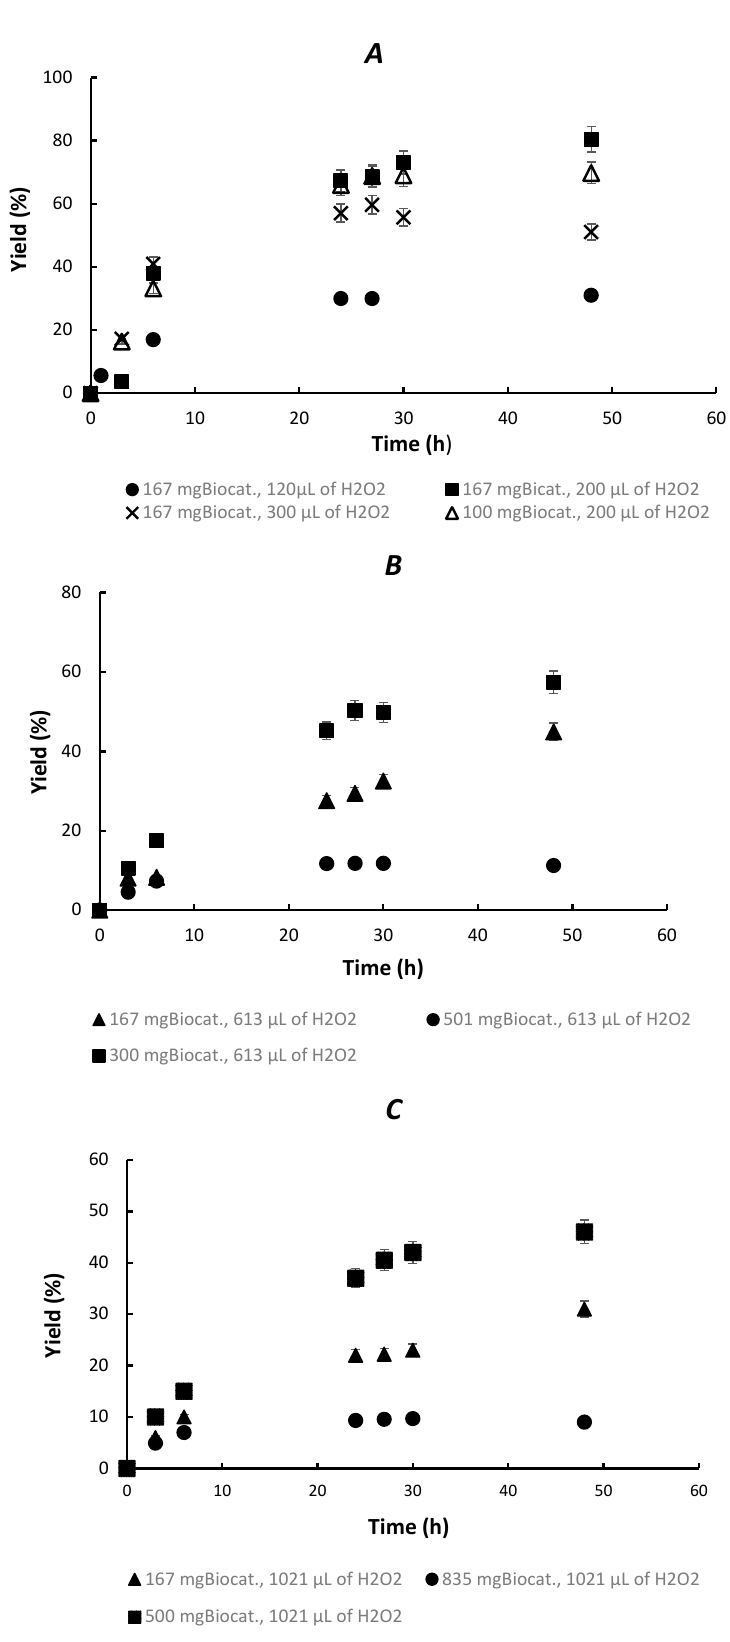
Figure 2. Chemoenzymatic synthesis of FDCA in a batch reactor. Operational conditions: 10 mL of reaction volume and 40 °C. ( A ) 10 mM of DFF; ( B ) 30 mM of DFF; ( C ) 50 mM of DFF.